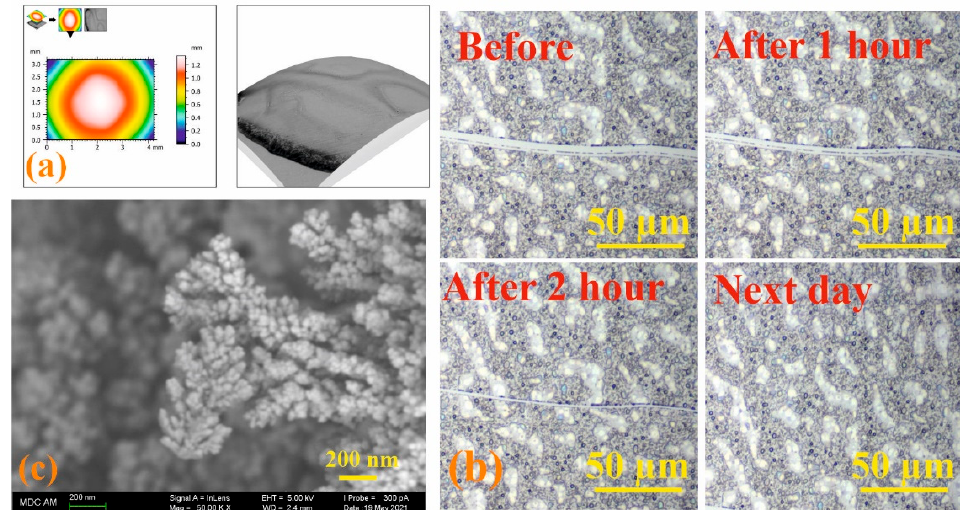
Figure 7. ( a ) SEM images of 3/4Sn at low pressure and topographic map of 3/4Sn film; ( b ) optical microscope image of a 3/4Sn film with surface disturbance over time (0–24 h); ( c ) SEM image of a section of a 3/4Sn film.